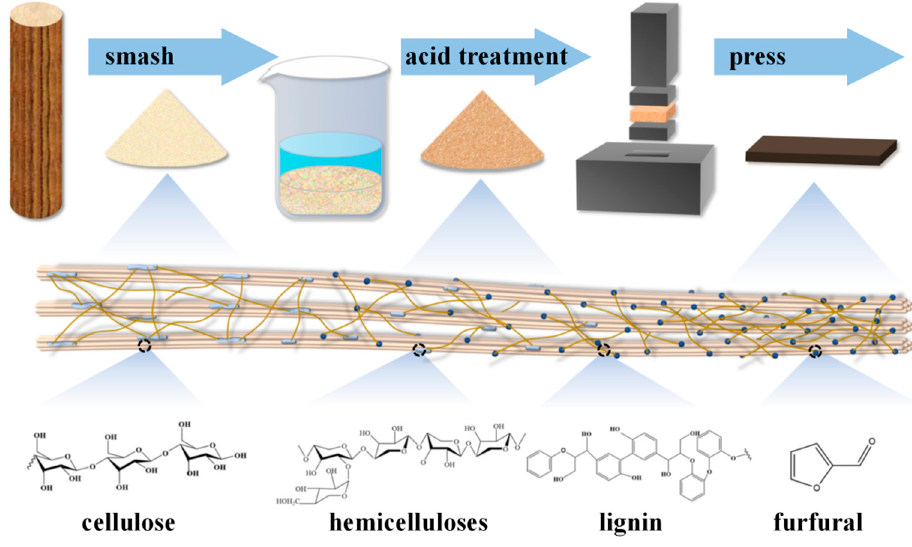
Figure 1. Preparation process of environmentally friendly glueless boxwood panels.